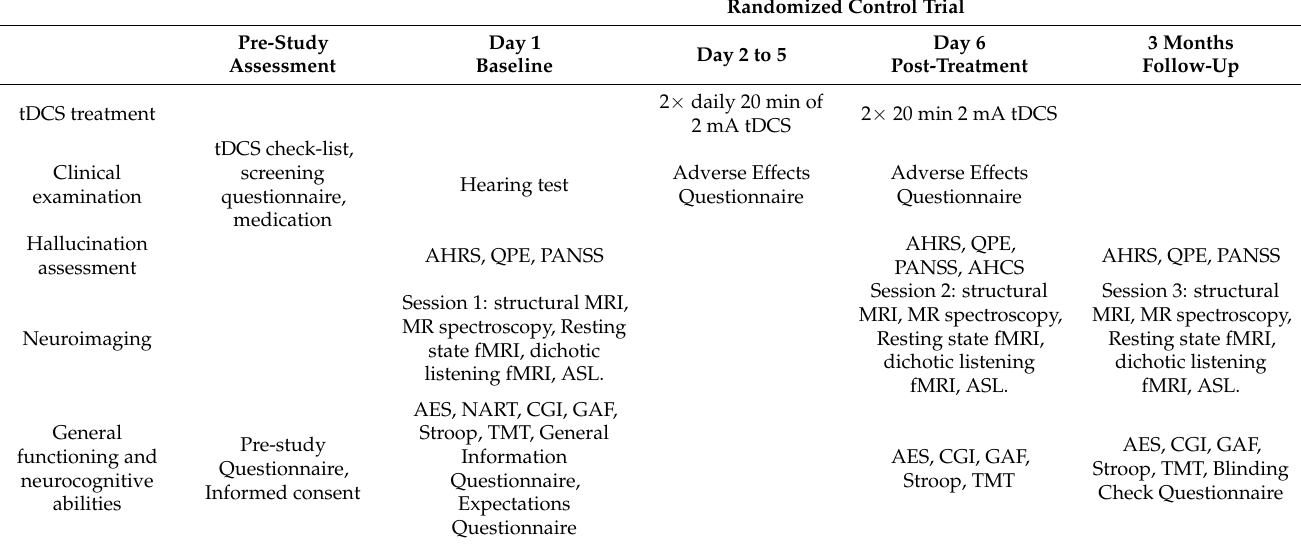
Table 2. Overview of the procedure and timeline of the RCT is